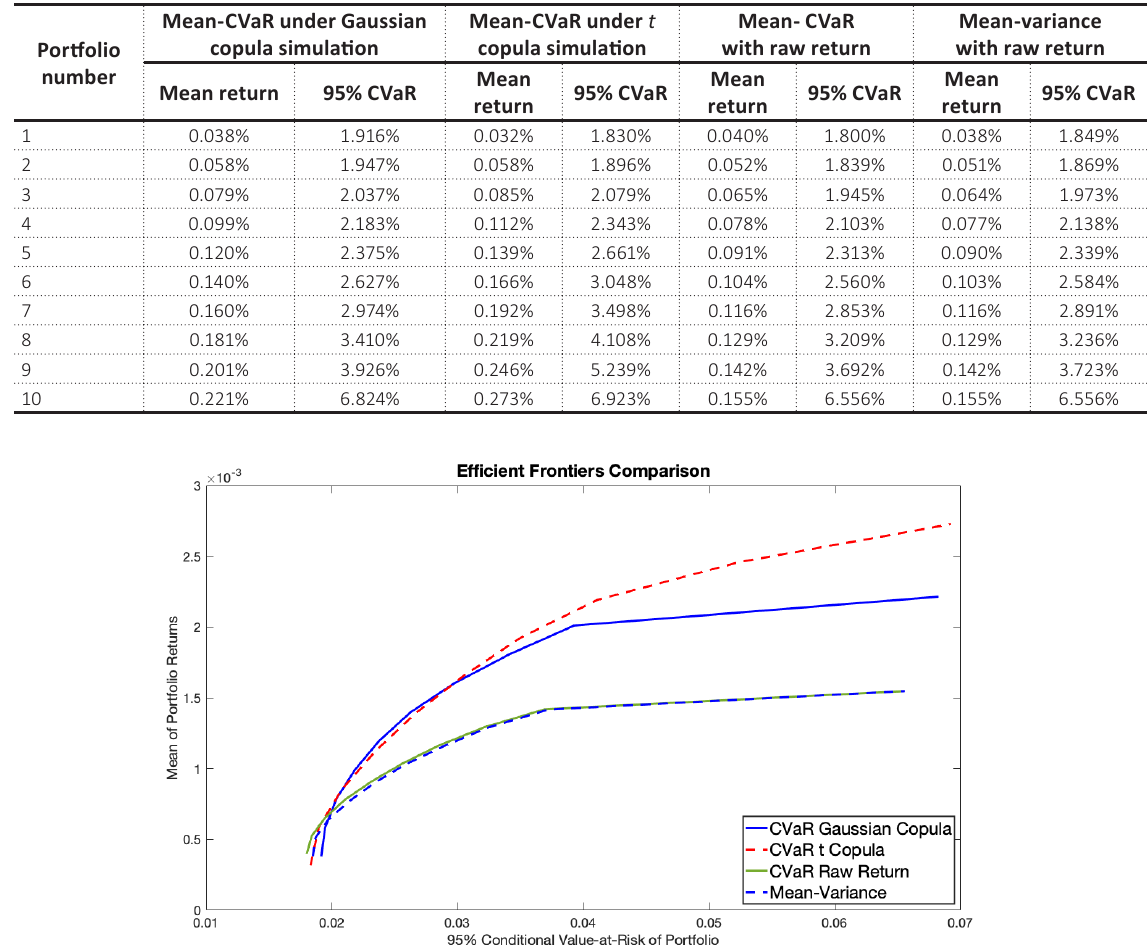
Table 3. Mean returns and 95% CVaR of 10 portfolios in each case (23 random stocks) Portfolio number